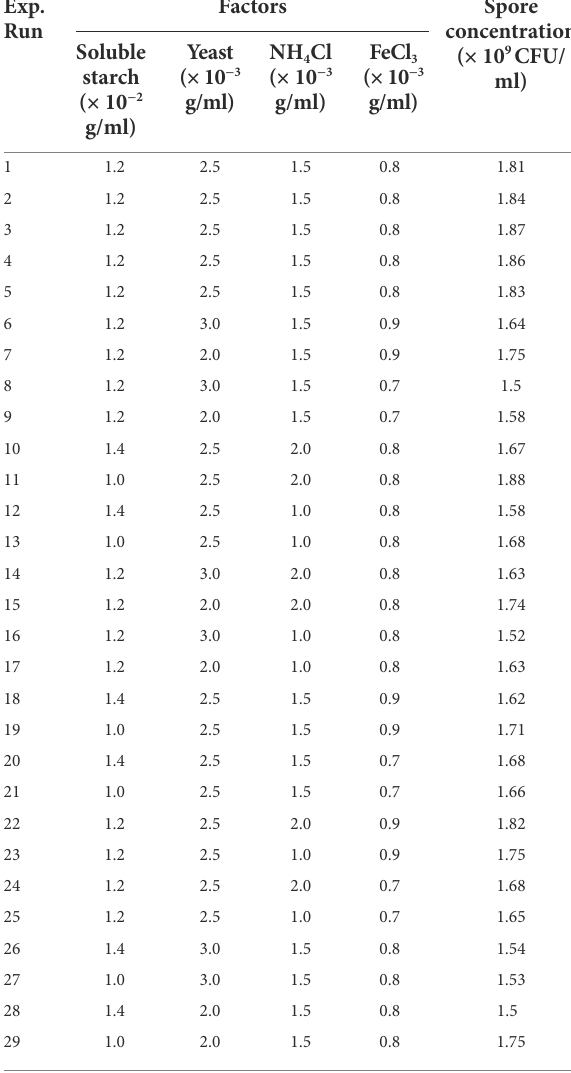
TABLE 5 Response surface methodology design and results. Exp. Factors Run